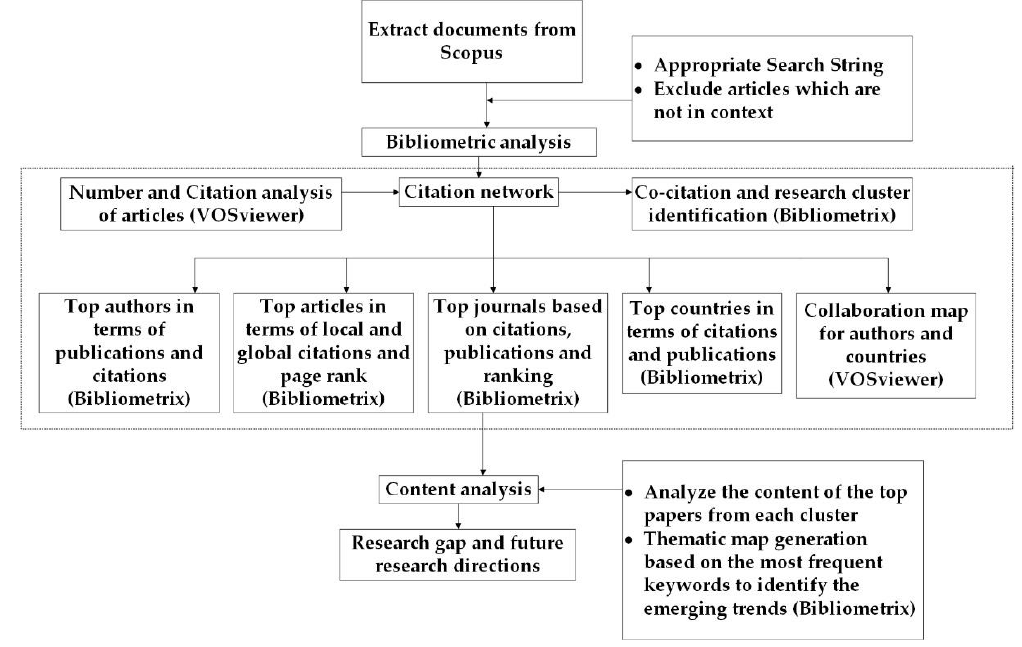
Figure 2. Overall